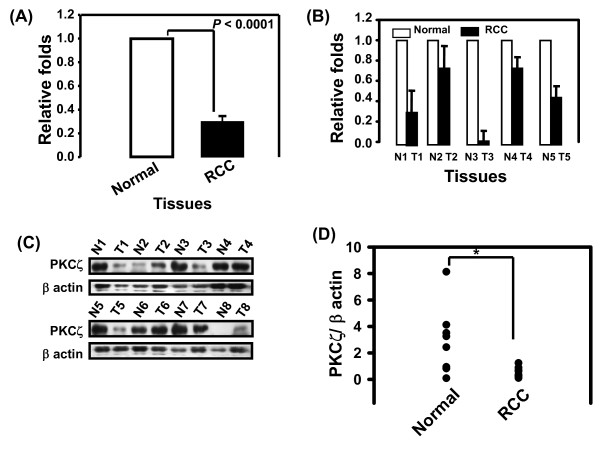
Down-regulation of PKCζ in RCC tissues. (A) Expression of PKCζ mRNA in 3 pairs of RCC and adjacent normal kidney tissues from 3 patients by cDNA microarray analysis. Fold change compared with normal kidney tissues. Paired sample t test was used to compare PKCζ expression in the normal and RCC tissues (*P < 0.001). (B) Real-time PCR analysis of PKCζ in 5 pairs of RCC (T) and adjacent normal kidney tissues (N) from 5 patients. (C) Expression of PKCζ protein in 8 pairs of normal and RCC tissues by Western blotting analysis. β-actin was used as an internal control (D) The ration of protein intensity of PKC ζ/β-actin from Figure 1(C) was examined by densitometer analysis. Paired sample t test was used to compare PKCζ expression in the normal and RCC tissues (*P < 0.05).